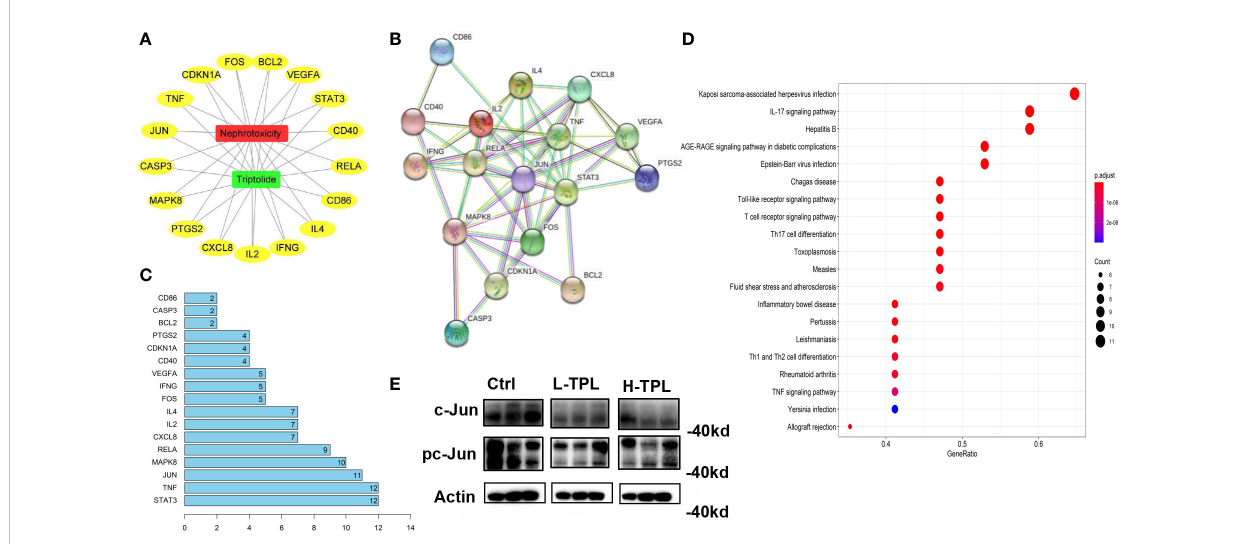
FIGURE 2 Target genes predicted to be associated with triptolide nephrotoxicity by network pharmacology-based analysis. (A) Visulization of interpalys between TPL and its predicted targets; (B) PPI network of TPL renal toxicity candidate target genes; (C) List of top 15 target genes ranked by contribution scores and they were regarded as candidate targeted genes related to TPL renal toxicity (CTGs-TPL); (D) KEGG terms of potential targets by gene enrichment analysis; (E) Western-blot assay of c-Jun and pc-Jun in Ctrl, L-TPL and H-TPL groups (from left to right, n =